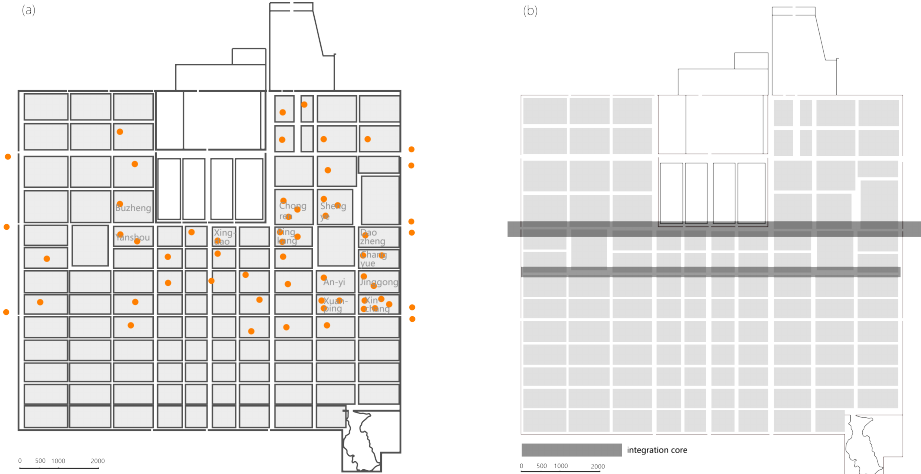
Figure 21. ( a ) Translated and drawn by the author from the distribution of commercial points in the Chang’an City prepared by SEO Tatsuhiko and Li Jianchao, “The Updating of the Two Capital of the Tang Dynasty [70]”; ( b ) the integration core of